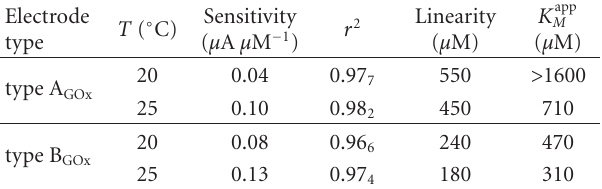
Table 3: Operational parameters of glucose oxidase enzyme elec- trodes; applied potential − 50mV (Ag/AgCl (1MKCl)); background electrolyte: phosphate-citrate bu ff er pH